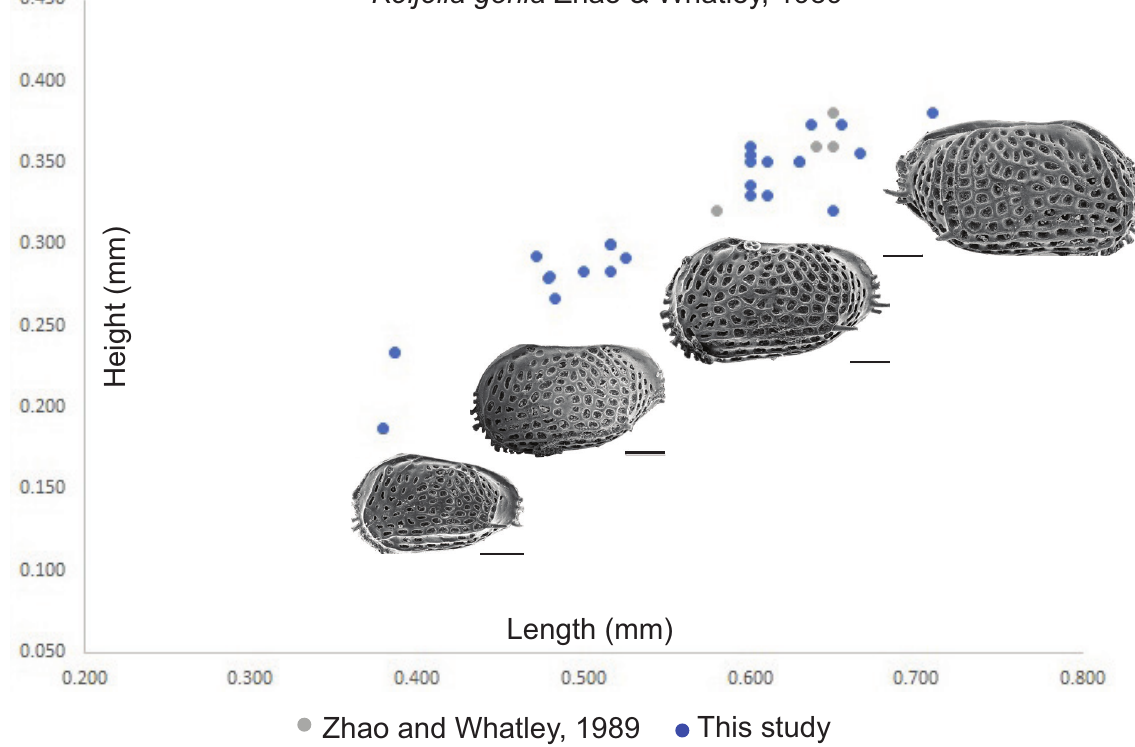
Fig. 10. Height and length scatter plots of Keijella gonia Zhao & Whatley, 1989 from Malaysia (grey circles) compared with specimens found from the whale-fall excavation site in Samut Sakhon Province, north of the Gulf of Thailand (blue circles). Scale bars = 0.1